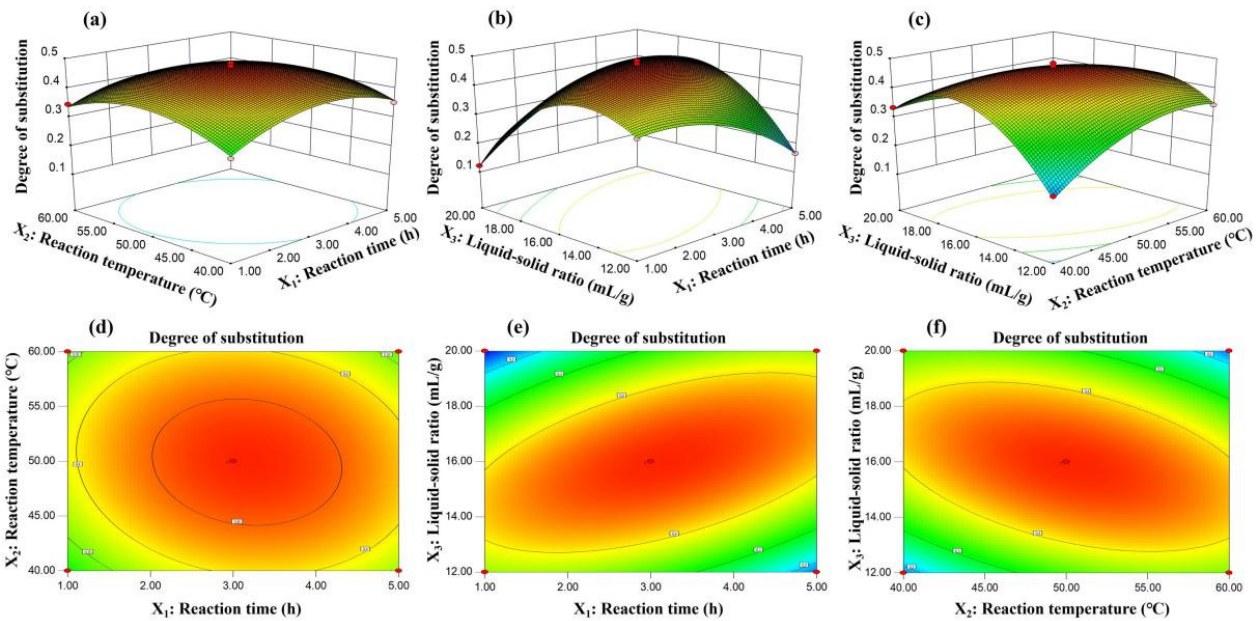
Figure 2. Three-dimensional (3D) and two-dimensional contour plots (2D) of the response surface and their mutual interactions on the degree of substitution of RDPs. ( a , d ) The reaction time/reaction temperature; ( b , e ) the reaction time/liquid-solid ratio; ( c , f ) the reaction temperature/liquid-solid ratio).